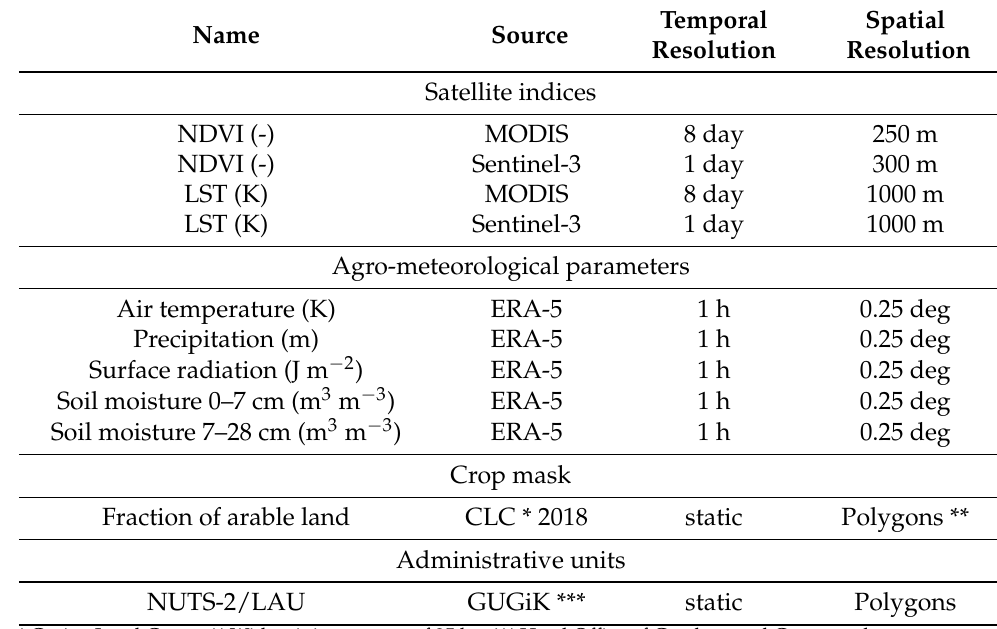
Table 1. Satellite, agro-meteorological, and ancillary data used to derive crop yield forecast